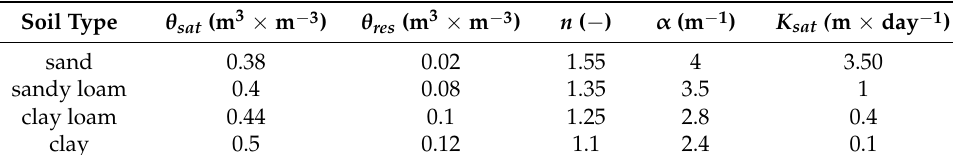
Table A1. VGM preset soil parameters. Values from Jabro (1992), Gootman et al. (2020), Hodnett & Tomasella, (2002) and Nemes et al. (2001) were considered and further modified.